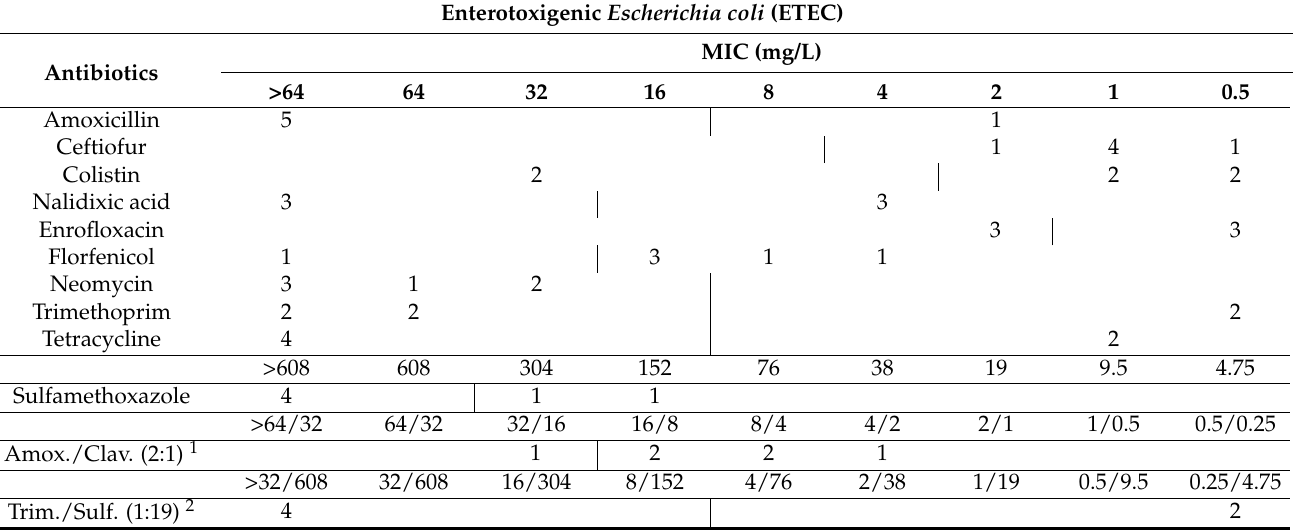
Table 1. Frequency of MIC values of 12 antibiotics (or combinations of antibiotics) against six field strains of ETEC. Vertical bars indicate MIC breakpoints as reported by EUCAST and CLSI [25–27]; values indicate the number of strains which reported a precise MIC value.